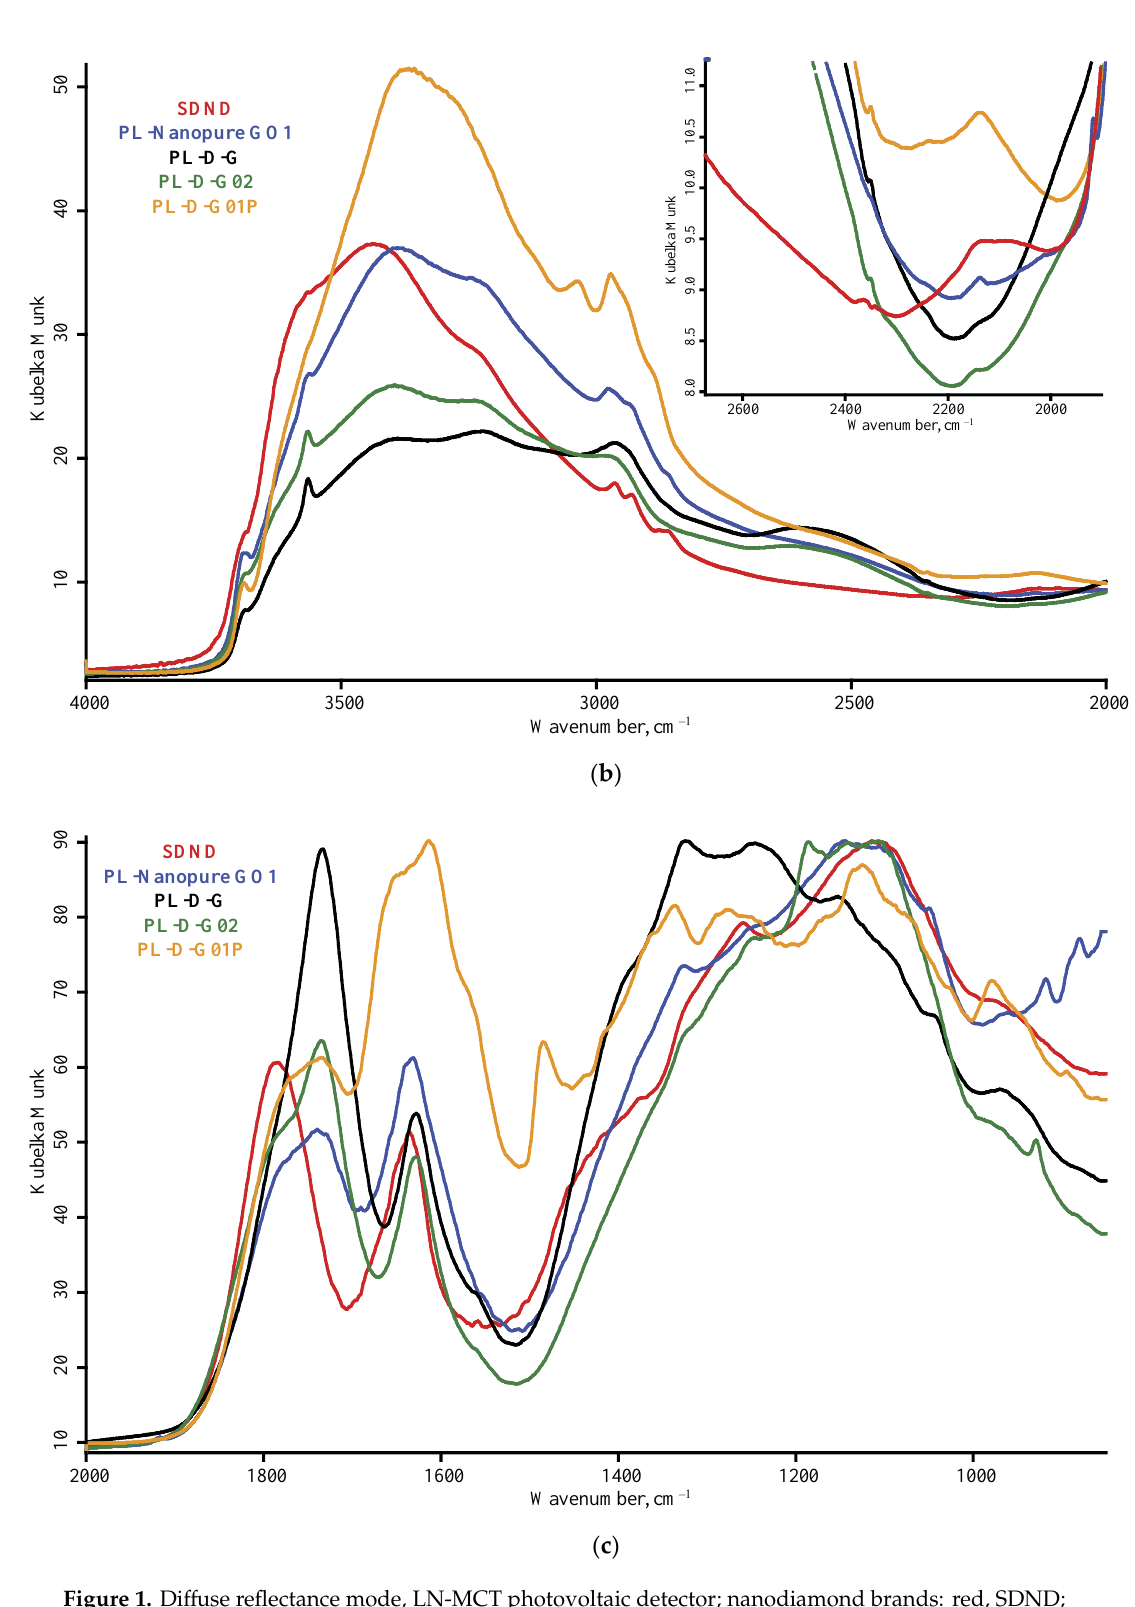
Figure 1. Diffuse reflectance mode, LN-MCT photovoltaic detector; nanodiamond brands: red, SDND; blue, PL-Nanopure GO1; black, PL-D-G; green, PL-D-G02; orange, PL-D-G01P; ( a ) 6000–4000 cm −1 , ( b ) 4000–2000 cm −1 ( c ) 2000–800 cm −1 range. Spectra are smoothed (13 points) and normalized to maximize each spectrum.